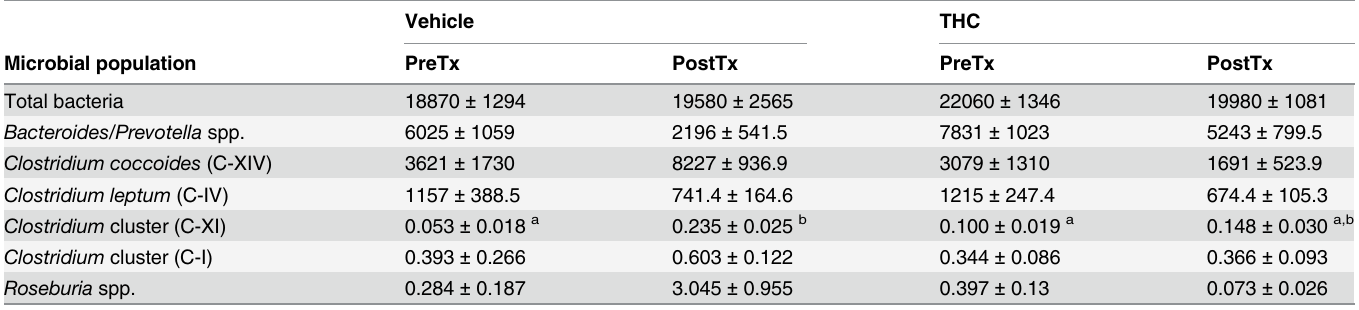
Table 2. Microbiota content in fecal matter of DIO mice prior to (Pretreatment, PreTx), and following (Posttreatment, PostTx) chronic administra- tion of Δ 9 -tetrahydrocannabinol (THC) or